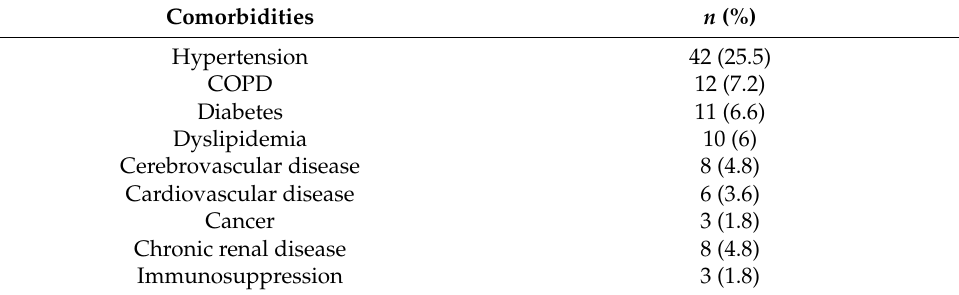
Table 1. Comorbidities proportion presented in